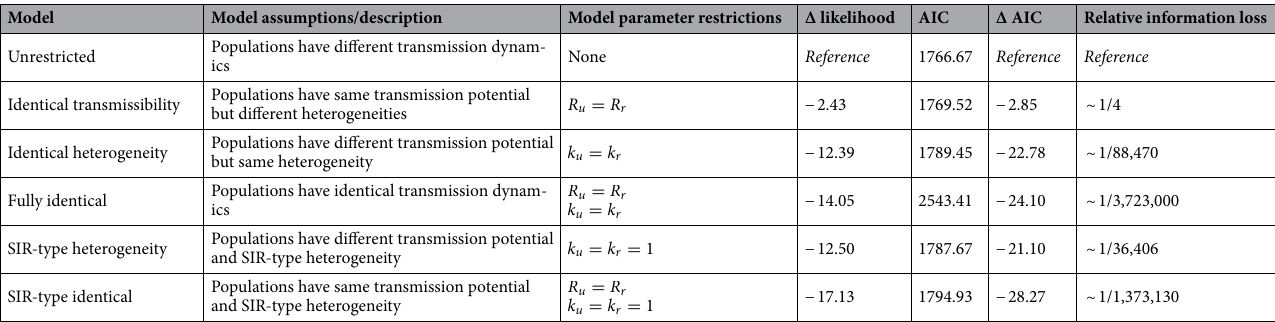
Table 3. Model results for comparing transmission dynamics in the urban and rural populations under various model assumptions.